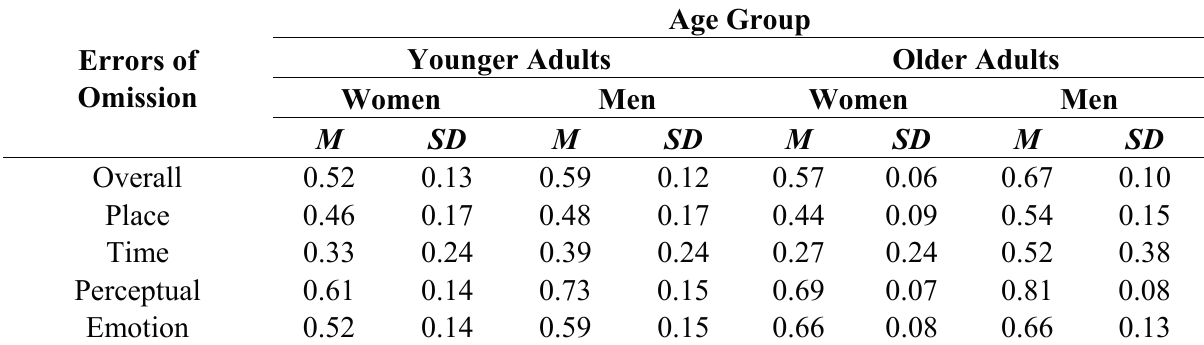
Table 5. Descriptive statistics for errors of omission for details overall and by category.